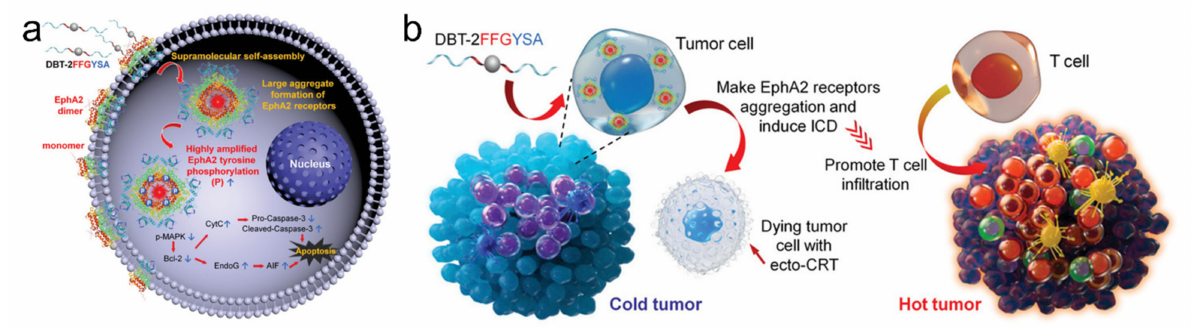
Figure 1. ( a ) Schematic diagram of DBT-2FFGYSA inducing EphA2 receptors form large aggregates beyond dimers. ( b ) Schematic diagram of the proposed mechanism for converting immunologically cold to hot tumors by DBT-2FFGYSA. Adapted with permission from [47]. Copyright 2021 John Wiley and